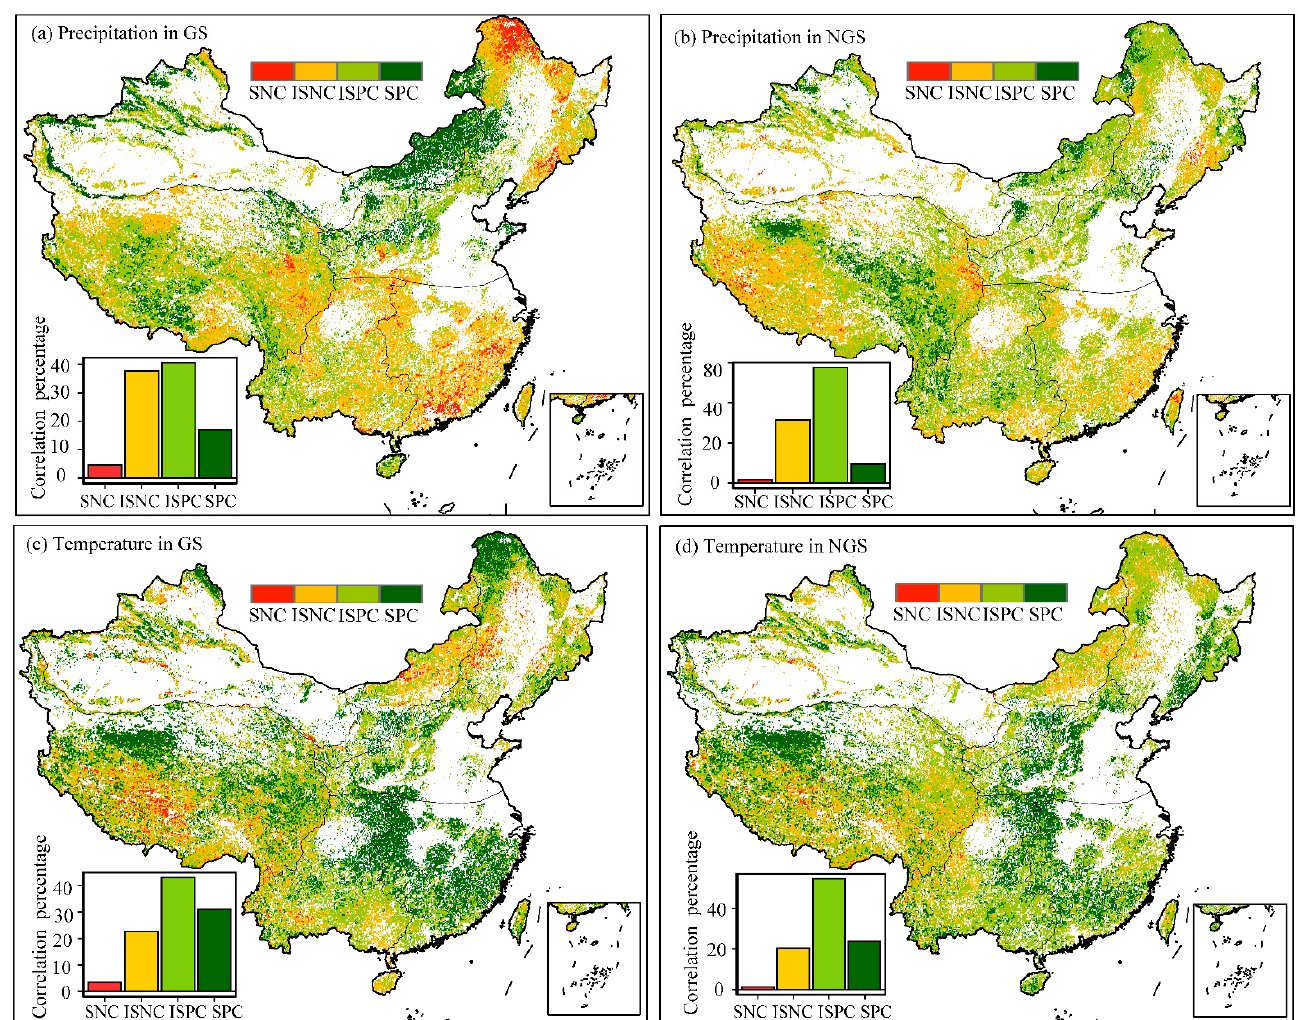
Figure 7. The correlation coefficients between the Normalized Difference Vegetation Index (NDVI) and climate variables in China. ( a , c ): Correlation between the growing season (GS) and the NDVI; ( b , d ): correlation between the GS NDVI and the previous non-growing season (NGS); SNC—Significant negative correlation; ISNC—Insignificant negative correlation; ISPC—Insignificant positive correlation; SPC—Significant positive correlation.